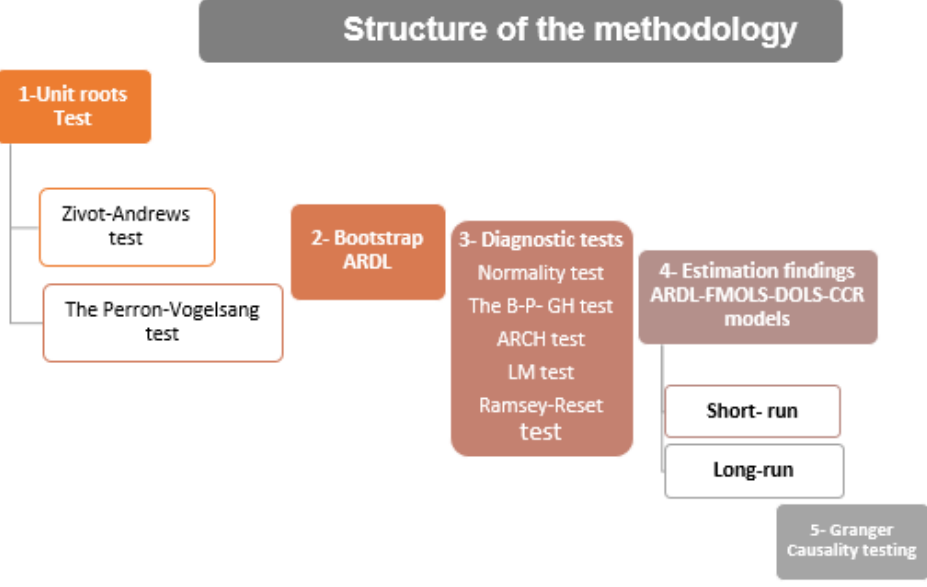
Figure 2. Structure of the methodology.